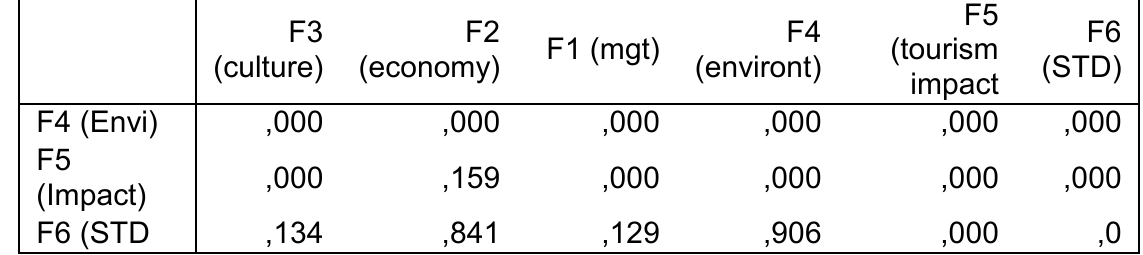
Table 7. Standardized Indirect